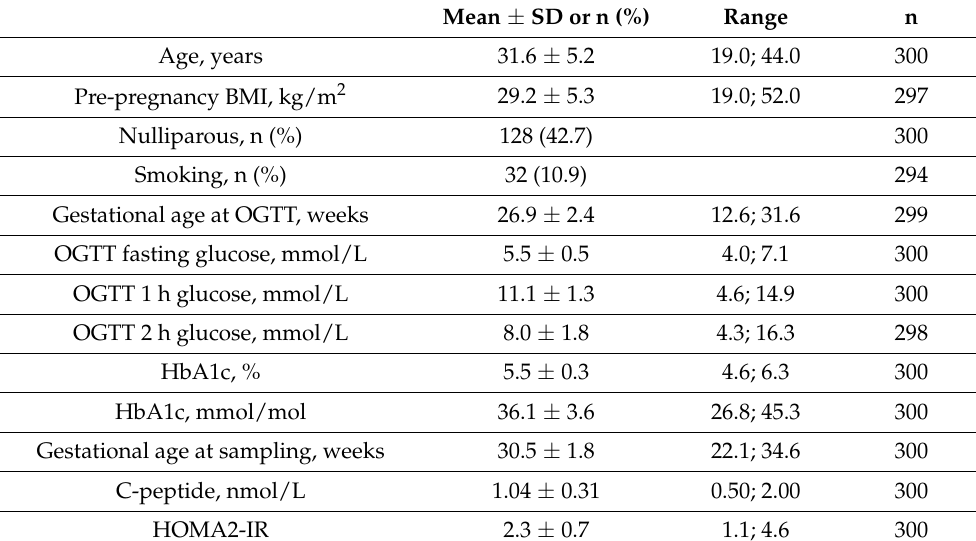
HOMA2-IR: homeostasis model assessment 2—insulin resistance.